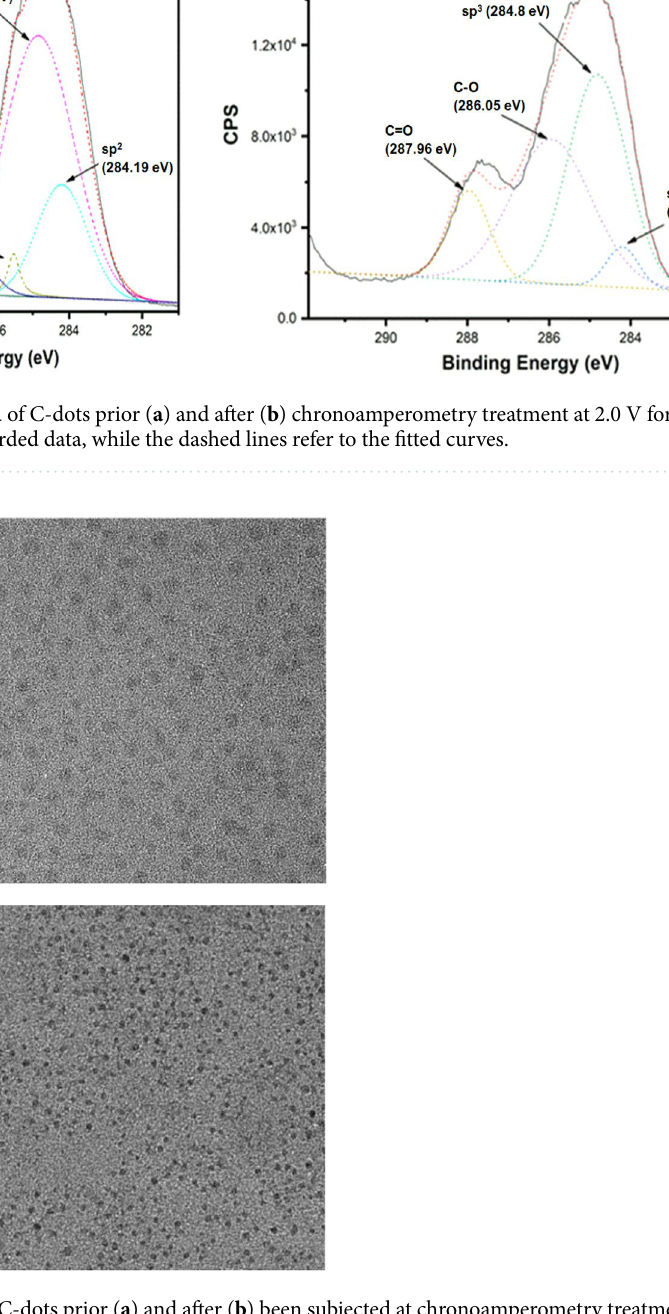
Figure 6. TEM images of C-dots prior ( a ) and after ( b ) been subjected at chronoamperometry treatment at 2.0 V for 60